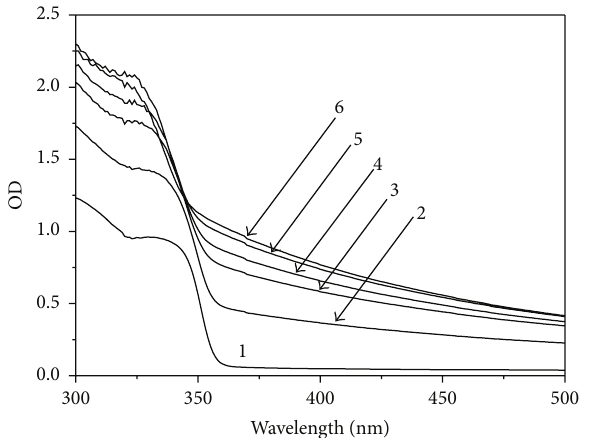
Figure 11: The dependence of the maximum of luminescence intensity of ZnO nanoparticles on the amount of silica added during the synthesis. [ZnO] = 2 × 10 −2 mol/L.